Question: What kind of plot is shown here?
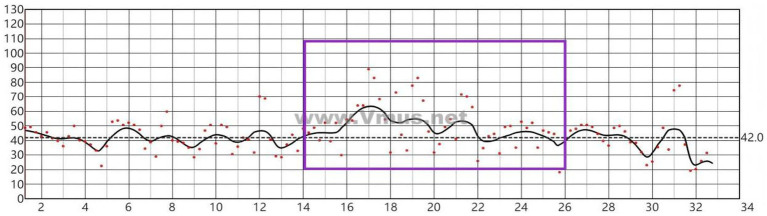
Answer: line